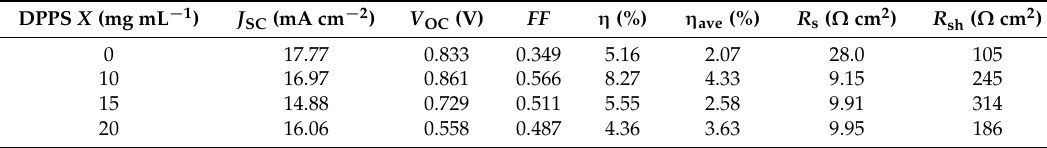
Table 1. Measured photovoltaic parameters of MAPbI 3 /(DPPS) ( X mg mL − 1 ) perovskite solar cells. DPPS X (mg mL − 1 )